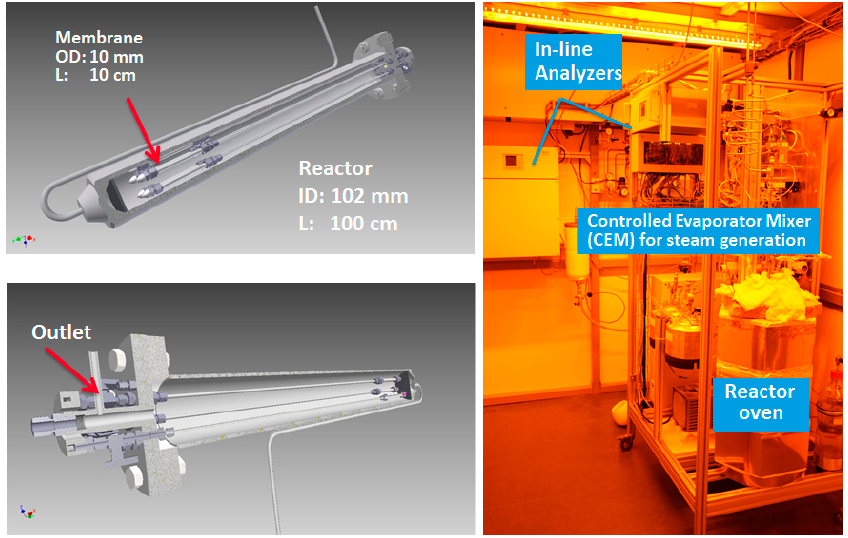
Figure 14. Fluidized bed membrane reactor setup ( right ); and membrane reactor module ( left ).